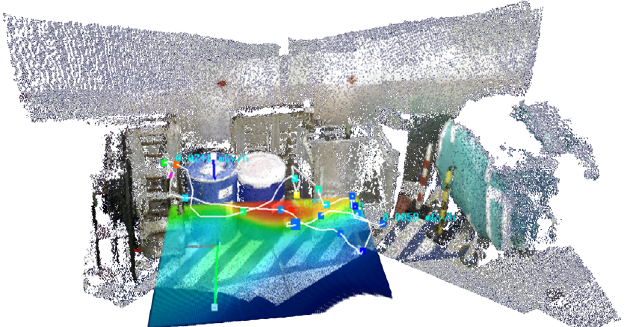
Fig. 10. Radioactive measurements 3D interpolation.